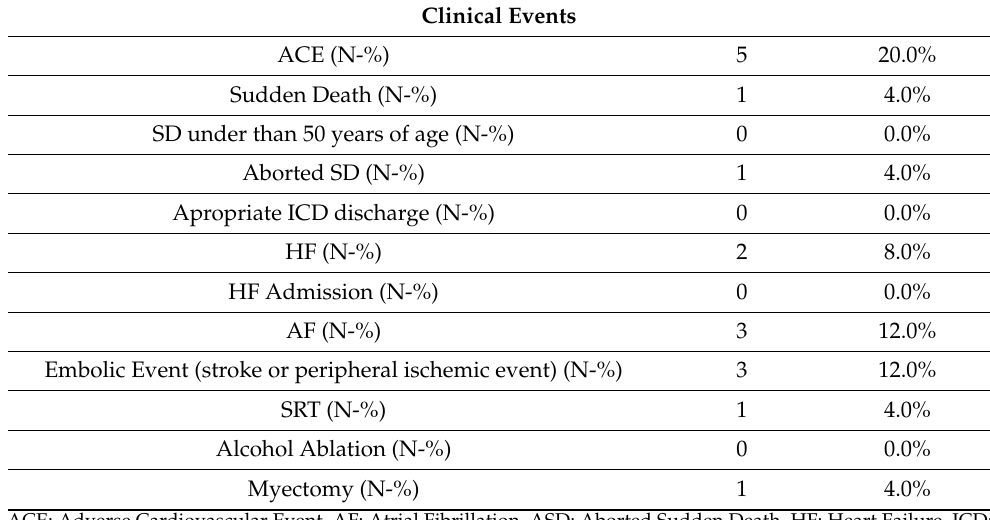
Table 3. Incidence of clinical events in patients with findings of the p.Arg652Lys variant in MYH7 . Clinical Events ACE (N-%) 5 20.0% Sudden Death (N-%) 1 4.0% SD under than 50 years of age (N-%) 0 Aborted SD